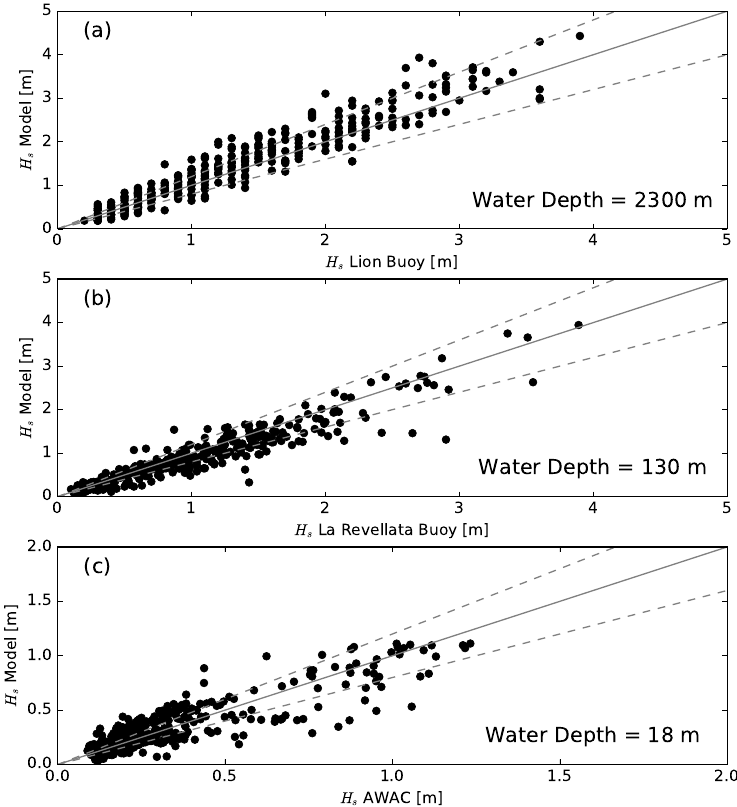
Figure 4. Scatter plots of computed versus observed H S for the period of the experiment (from 31 March to 15 May 2017). ( a ) Lion buoy; ( b ) La Revellata; ( c ) AWAC at Poetto beach. Solid line, perfect agreement; dashed line, 20% error bound.